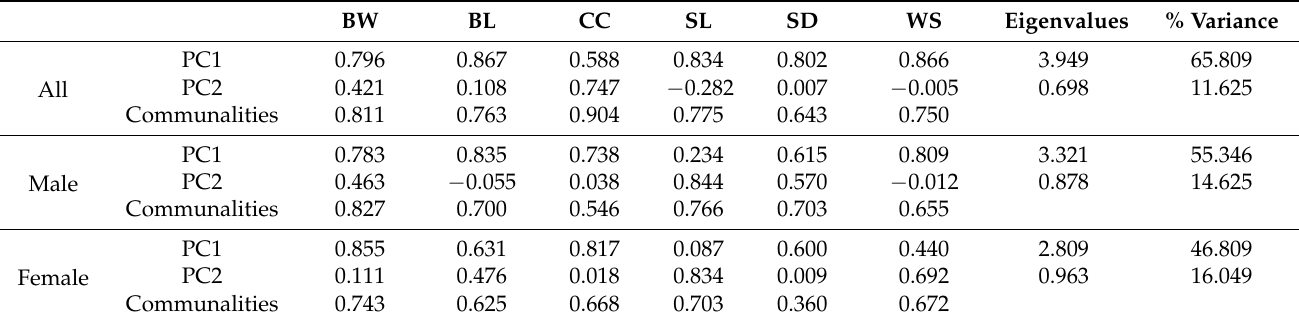
Table 7. Eigenvalues and percentage of Total Variance along with the rotated Component Matrix and Communalities of the zoometric measures and body weight of males and females.